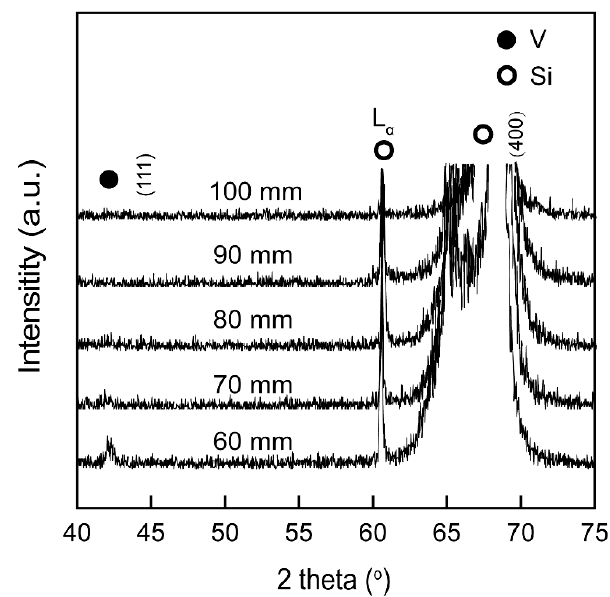
Figure 5. XRD patterns of V films deposited on Si (100) at T s = 400 °C with different D t-s .